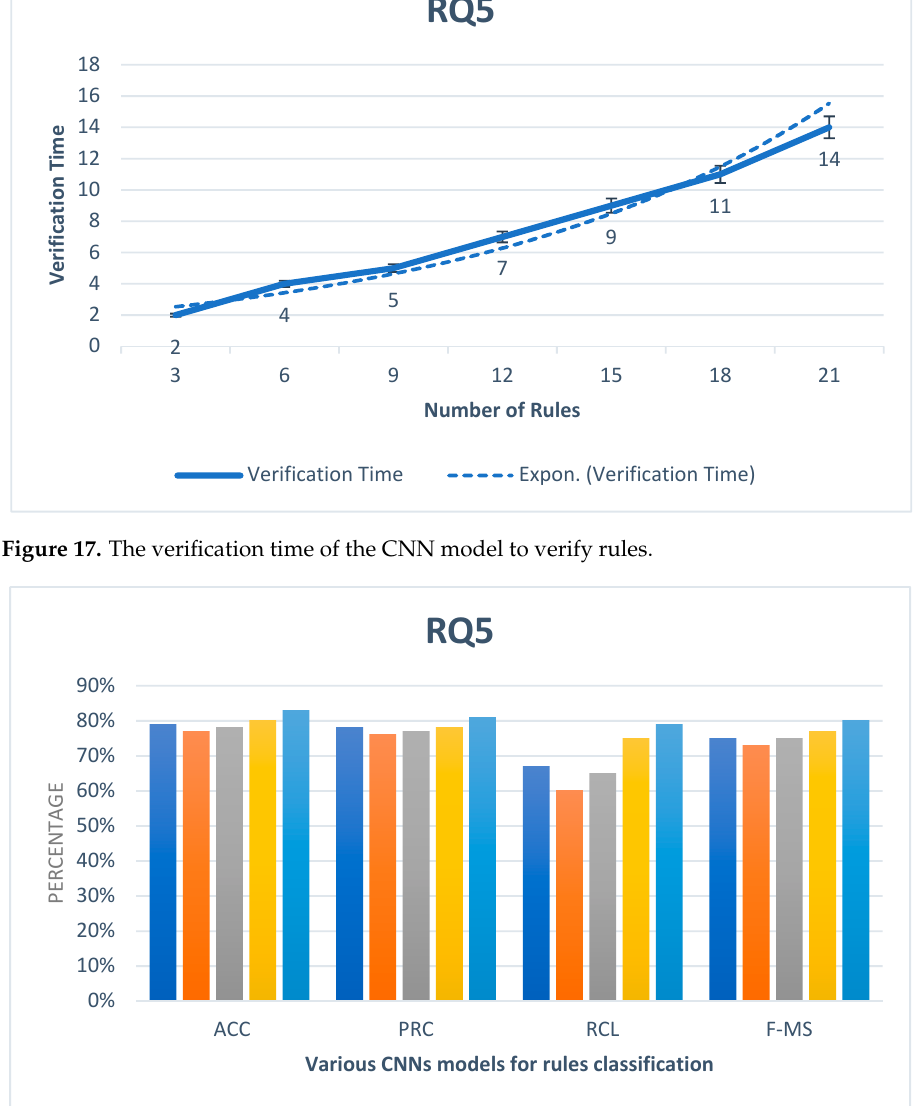
Figure 18. The comparison between various CNN models for rule classification.